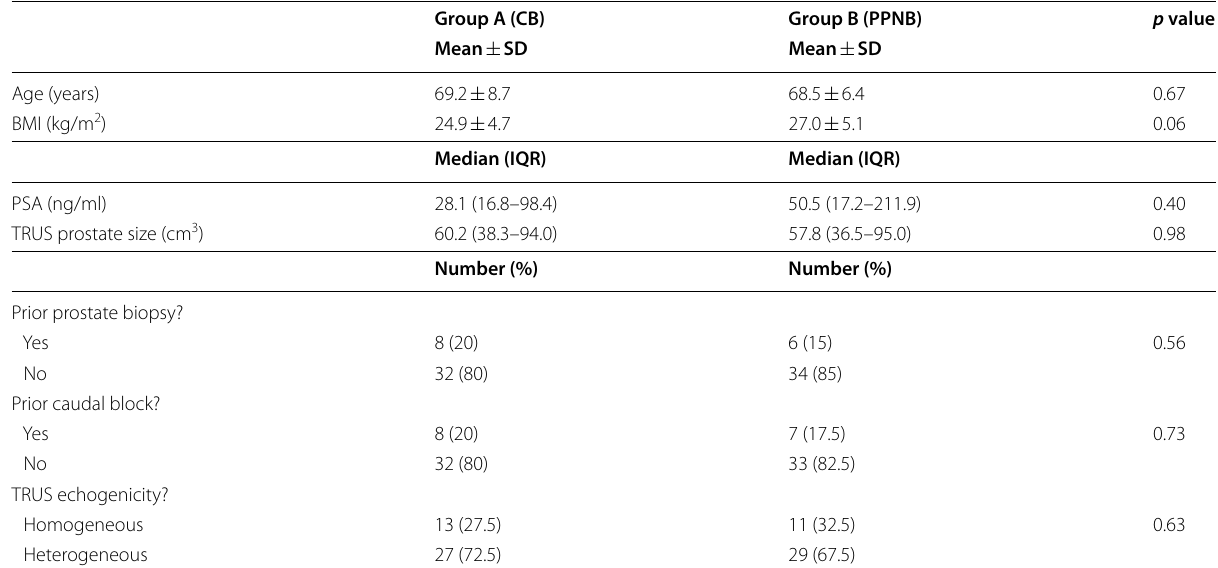
Table 1 Comparison of mean ages, BMI, PSA, TRUS prostate volumes, prior procedures and TRUS prostate findings between the group A and group